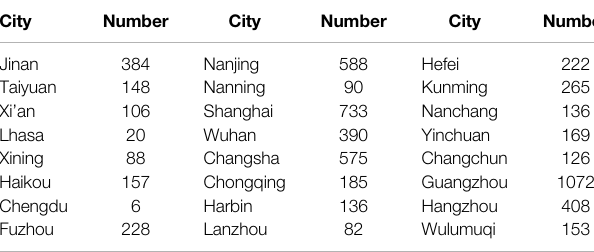
TABLE 1 | The number of rock and soil samples for provincial capital